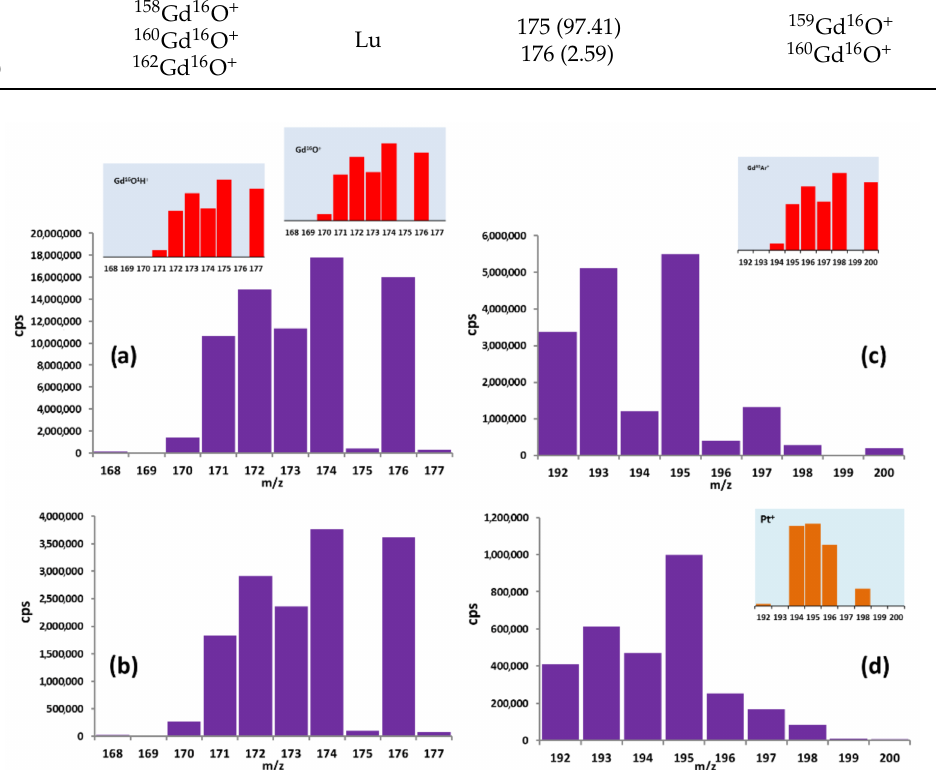
Figure 1. Mass spectra of the sample with a Gd concentration of 0.001 wt% obtained in different modes: ( a ) standard; ( b ) KED for m/z 168–177; ( c ) standard; ( d ) KED for m/z